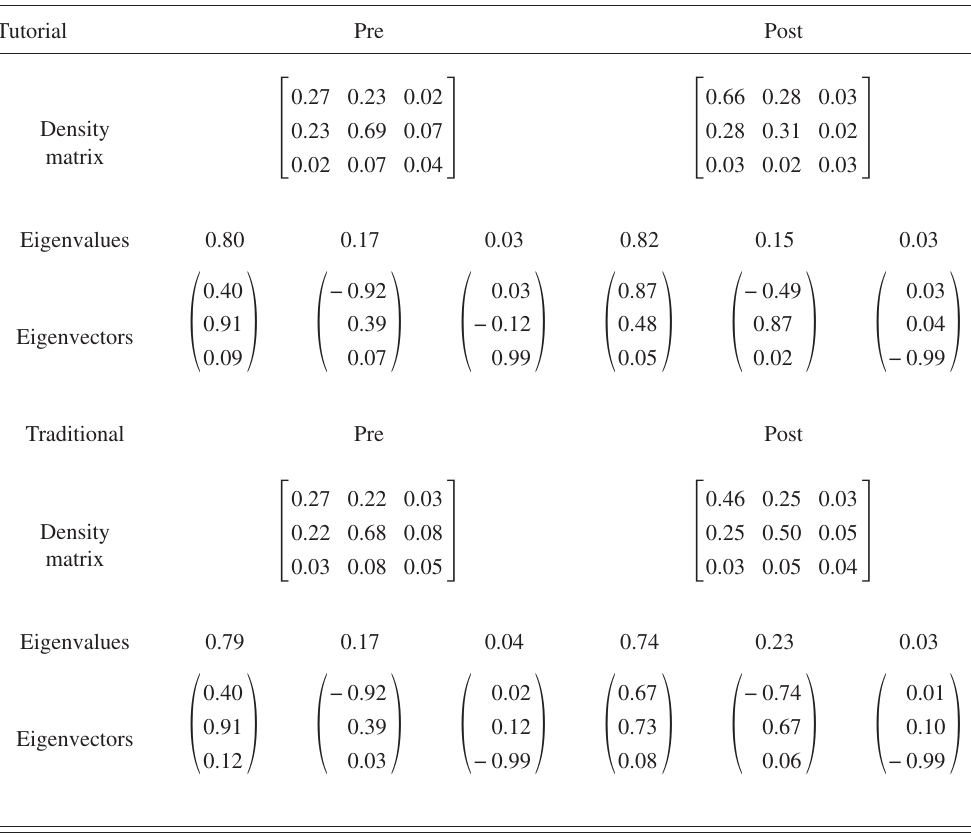
TABLE II. Results of class model density matrices and class model states on the force-motion concept with data from UMD